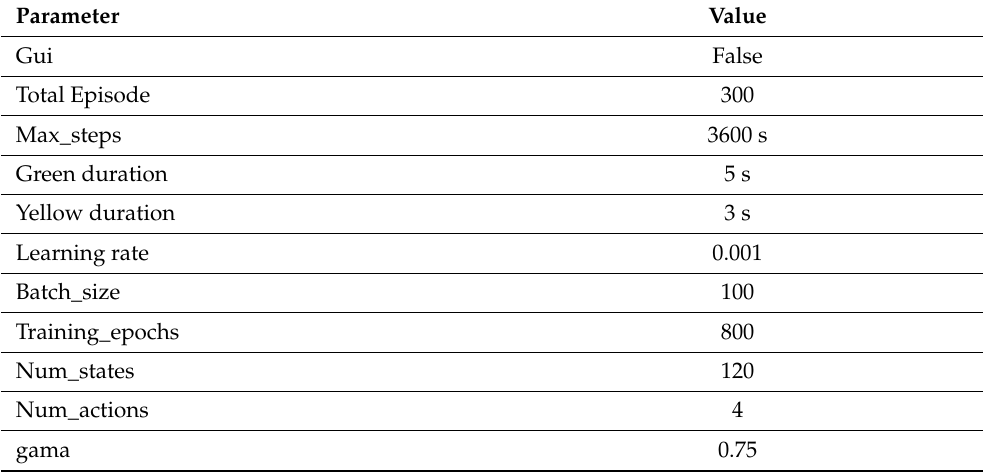
Table 3. Parameters of